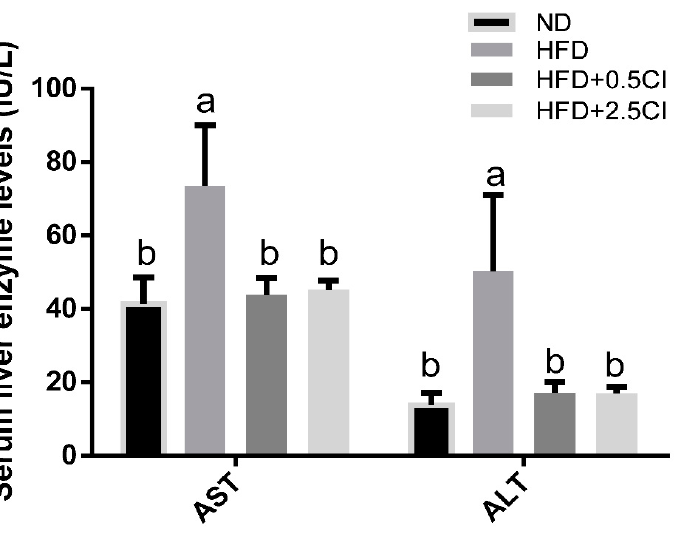
Figure 2. Effects of Chiliadenus iphionoides supplementation on serum liver enzymes. Male C57BL/6J mice were fed with normal diet (ND), high-fat diet (HFD), high-fat diet + 0.5 mg/kg Chiliadenus iphionoides (HFD + 0.5CI), high-fat diet + 2.5 mg/kg Chiliadenus iphionoides (HFD + 2.5CI) for fifteen weeks. Values are expressed as mean ± SEM ( n = 6). Different letters denote significant difference ( p < 0.05, Tukey’s HSD). AST—aspartate aminotransferase, ALT—alanine aminotransferase.